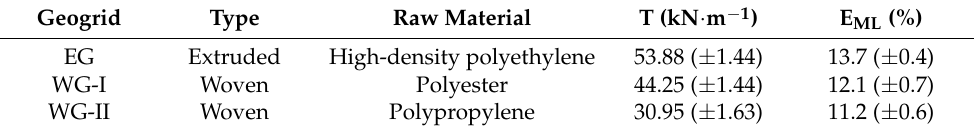
Table 1. Properties of geogrids.